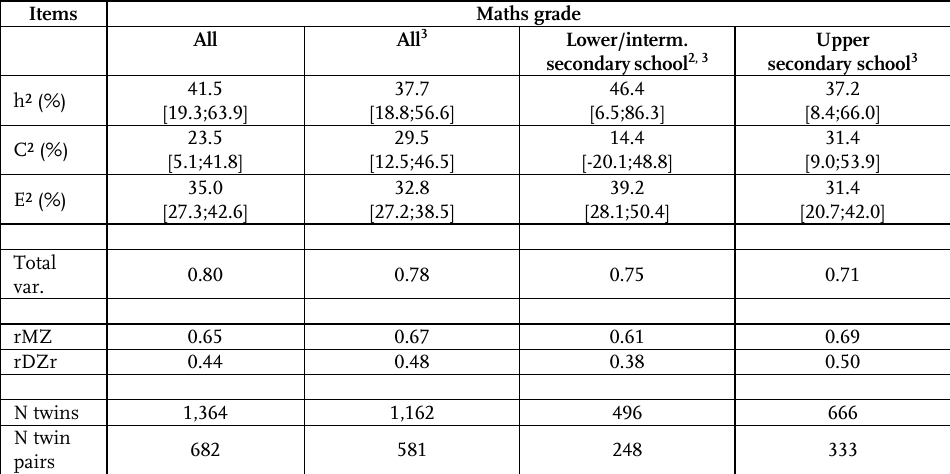
Table 5 : Results of multilevel mixed-effects ACE variance decomposition models, confidence intervals in brackets